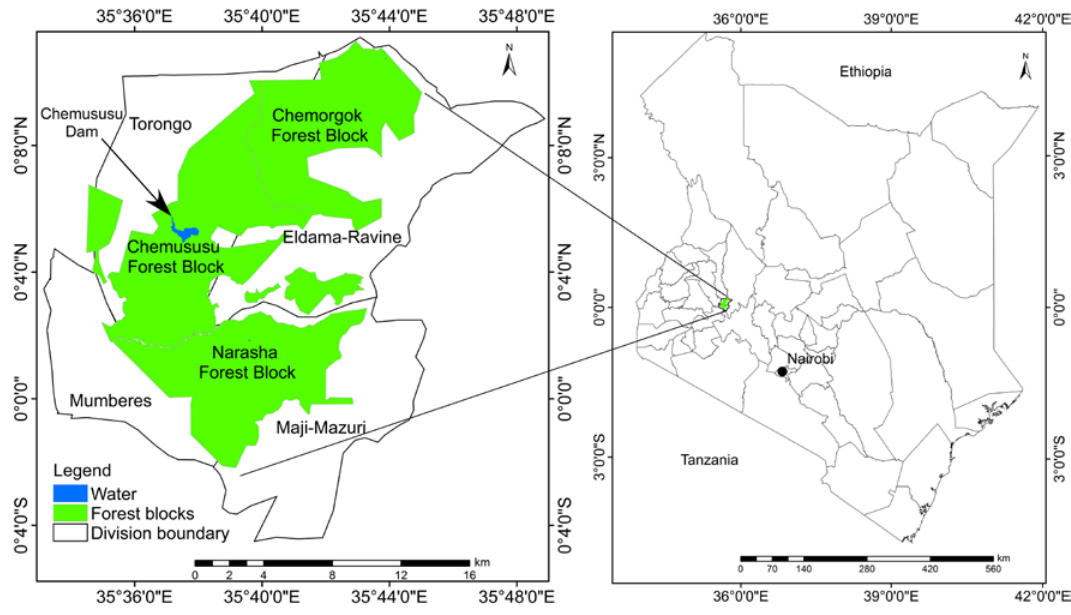
Figure 1. Geographic location and extent of the Lembus Forest.